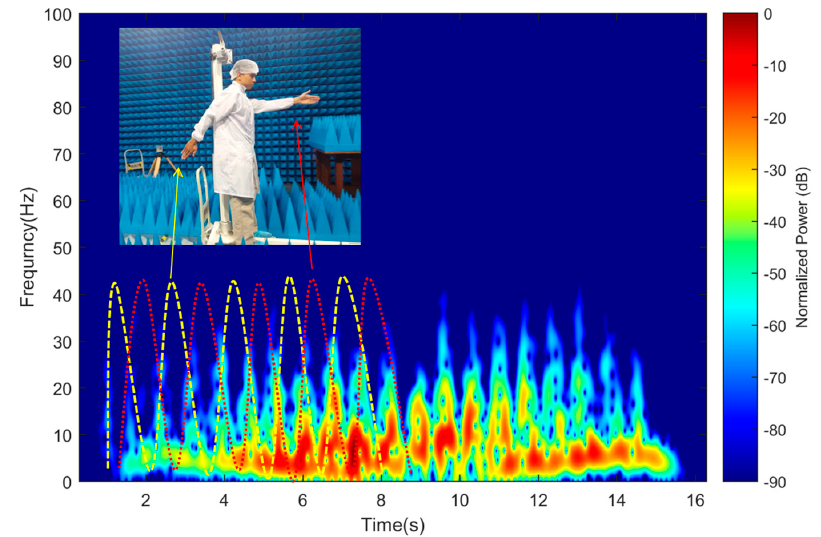
Figure 23. Spectrogram of Doppler signature for man standing on a moving trolley with two hands swinging.